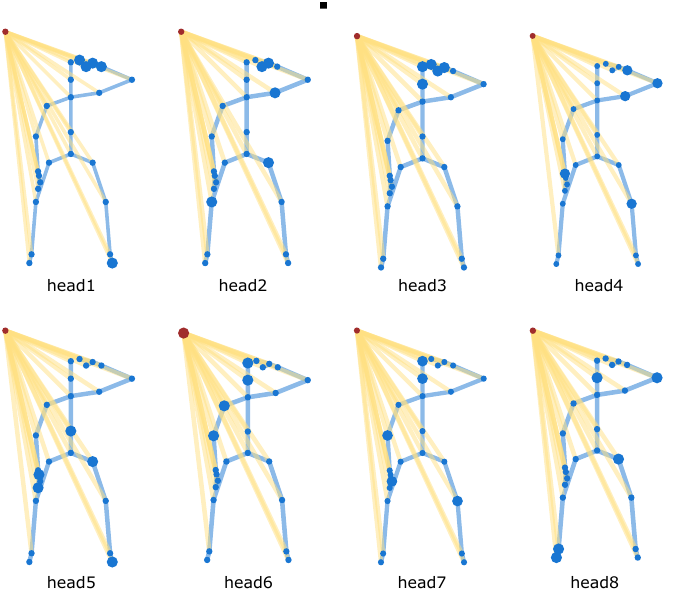
Figure 8. Visualization of the attention responses of the last SRU block in ST-RT model the action is salute.